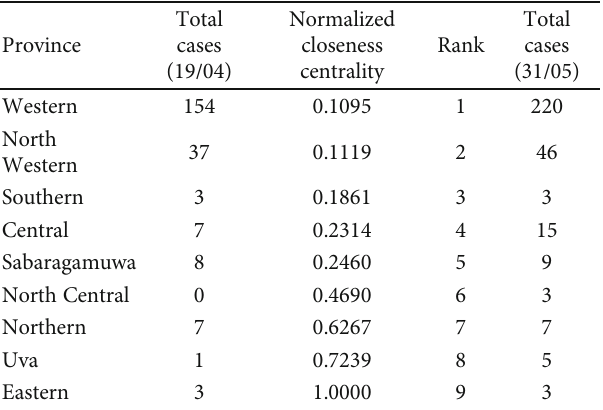
Figure 11: Estimated provincial infected population based on interprovincial Table 2: Total reported COVID-19 cases (up to 19 th April 2020 and up to 31 st May 2020) and normalized closeness centrality results with ranking of the provinces in Sri Lanka.